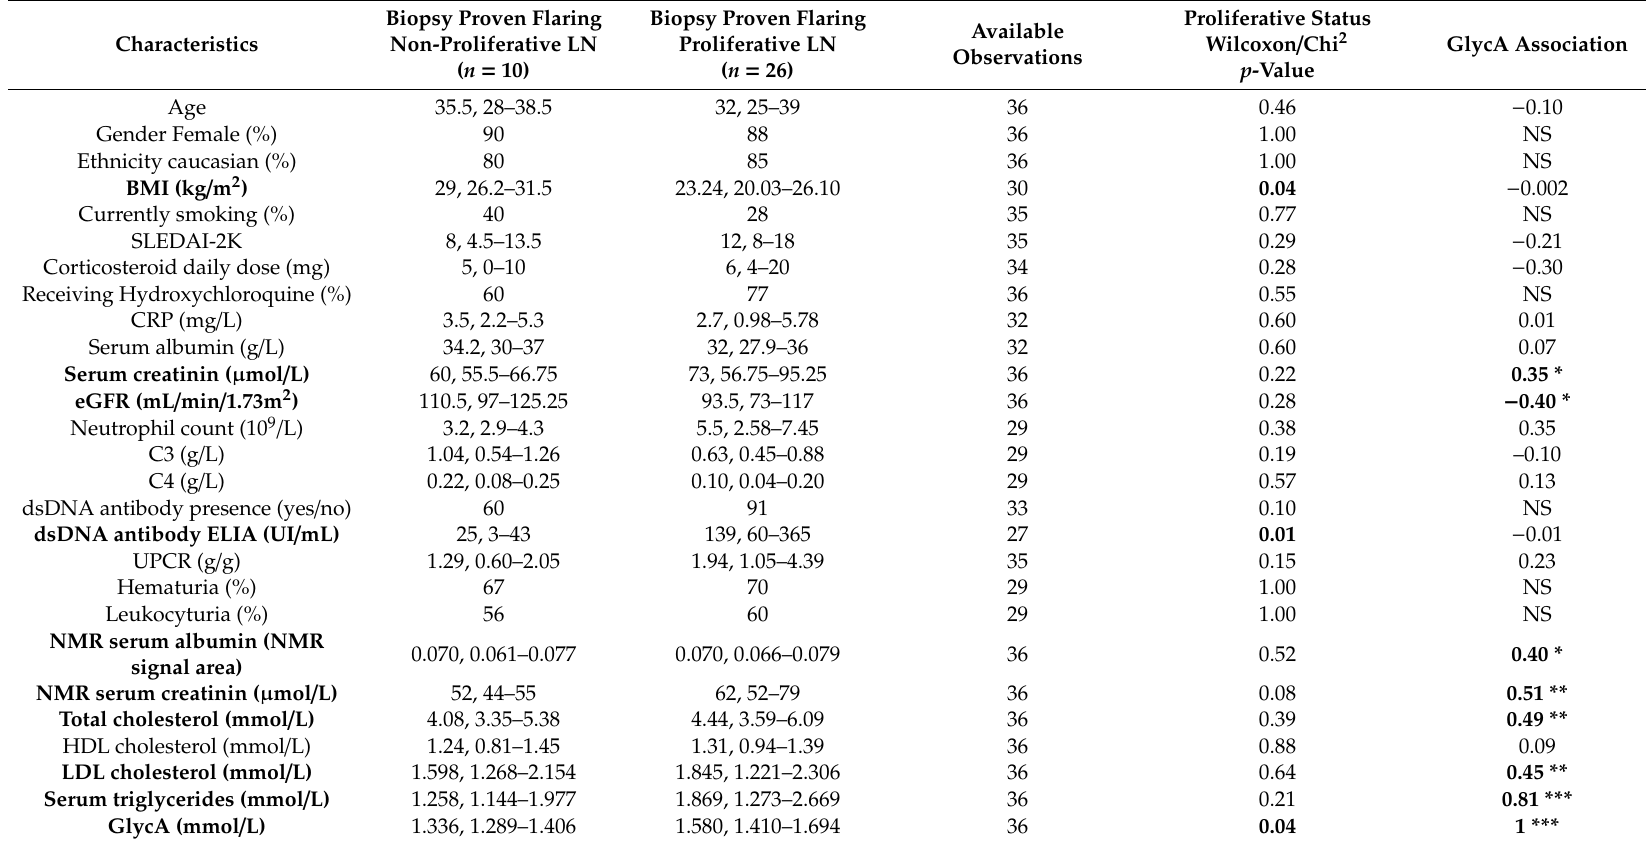
Table 3. Summary statistics and GlycA association tests in patients with biopsy-proven lupus nephritis at the time of